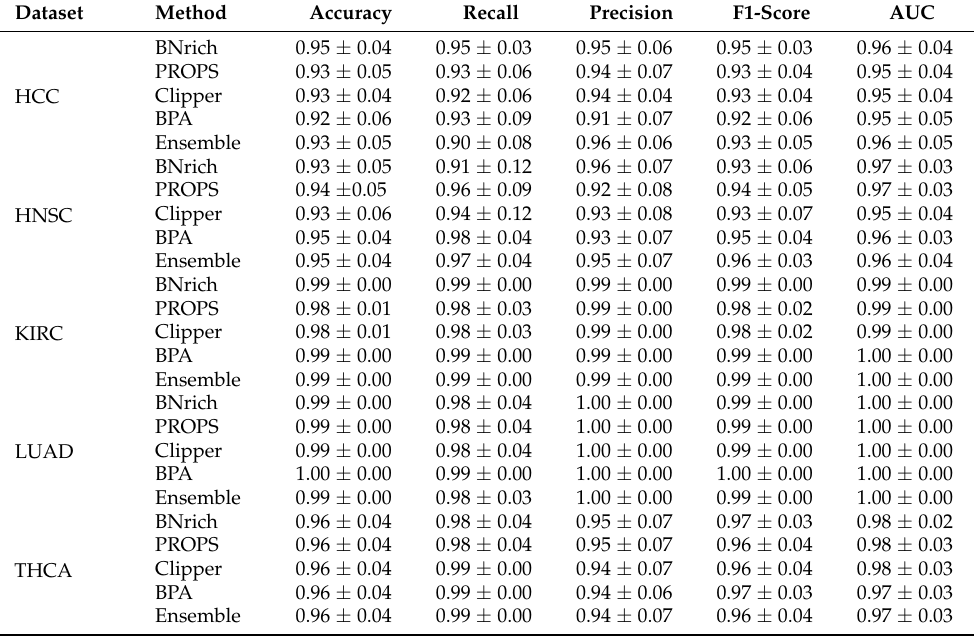
Table 2. Tumor and normal tissue classification performance based on pathways reconstructed by BNrich, PROPS, Clipper, BPA, and Ensemble method. The thresholds for accuracy, recall, precision, and F1-score were set to be the one that obtains the best MCC score.